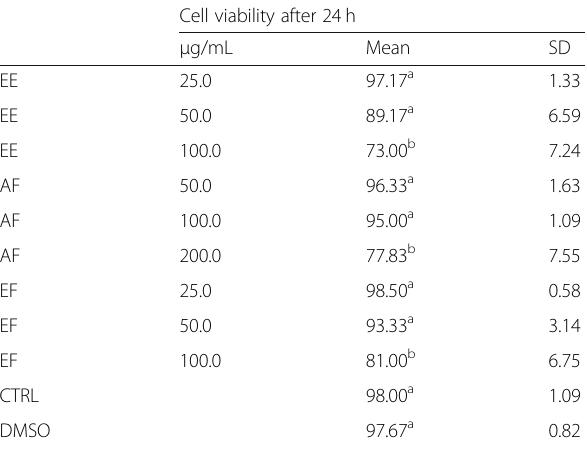
Table 1 Effect of EE extract and AF and EF fractions from stem bark of L . ochrophylla on cell viability after 24 h of culture